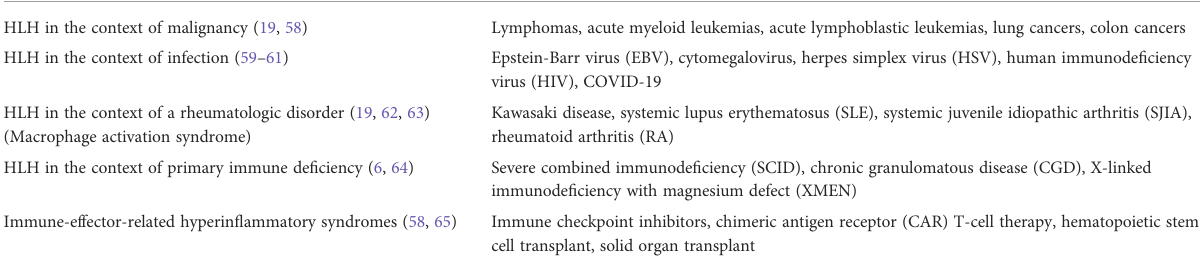
TABLE 3 Secondary HLH.